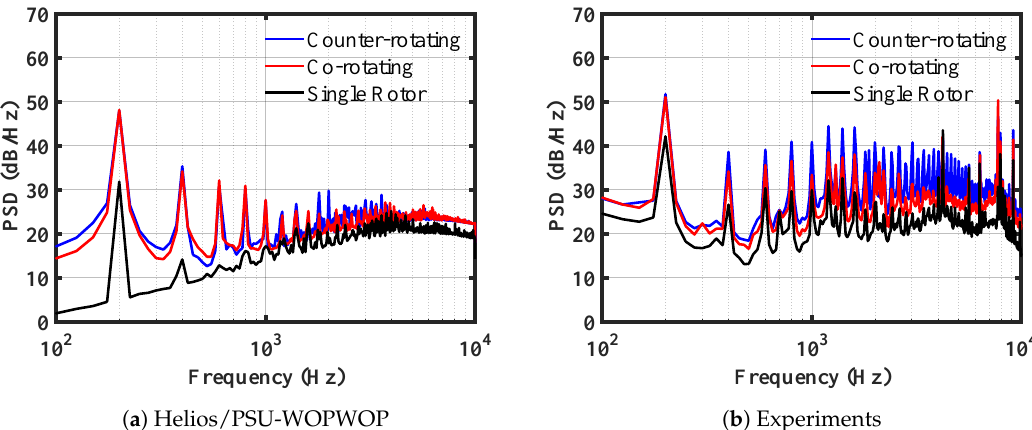
Figure 17. Computations using Helios/PSU-WOPWOP and UCD-Quietfly ( a ) and experimental measurements ( b ) of the dual rotor configurations with a separation distance of t = 0.04 d at mic 3 of the linear array. The results of the isolated rotor are also included for